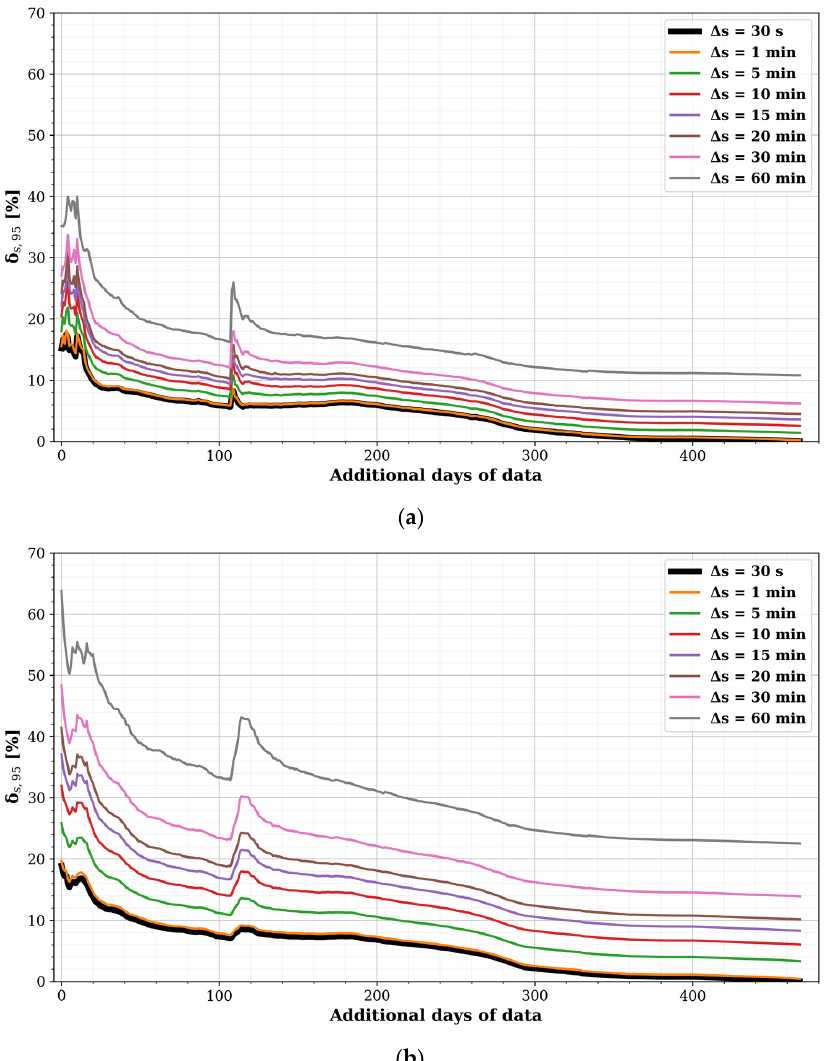
Figure 11. Sensor-averaged sampling errors Δ s,95 induced in ( a ) TP D and ( b ) TP W for 1800 MHz with a resolution of Δ t = 60 min, when using different sampling times Δ s between 1 and 60 min, as a function of the additional days of measurement data after an initial 7-day period.